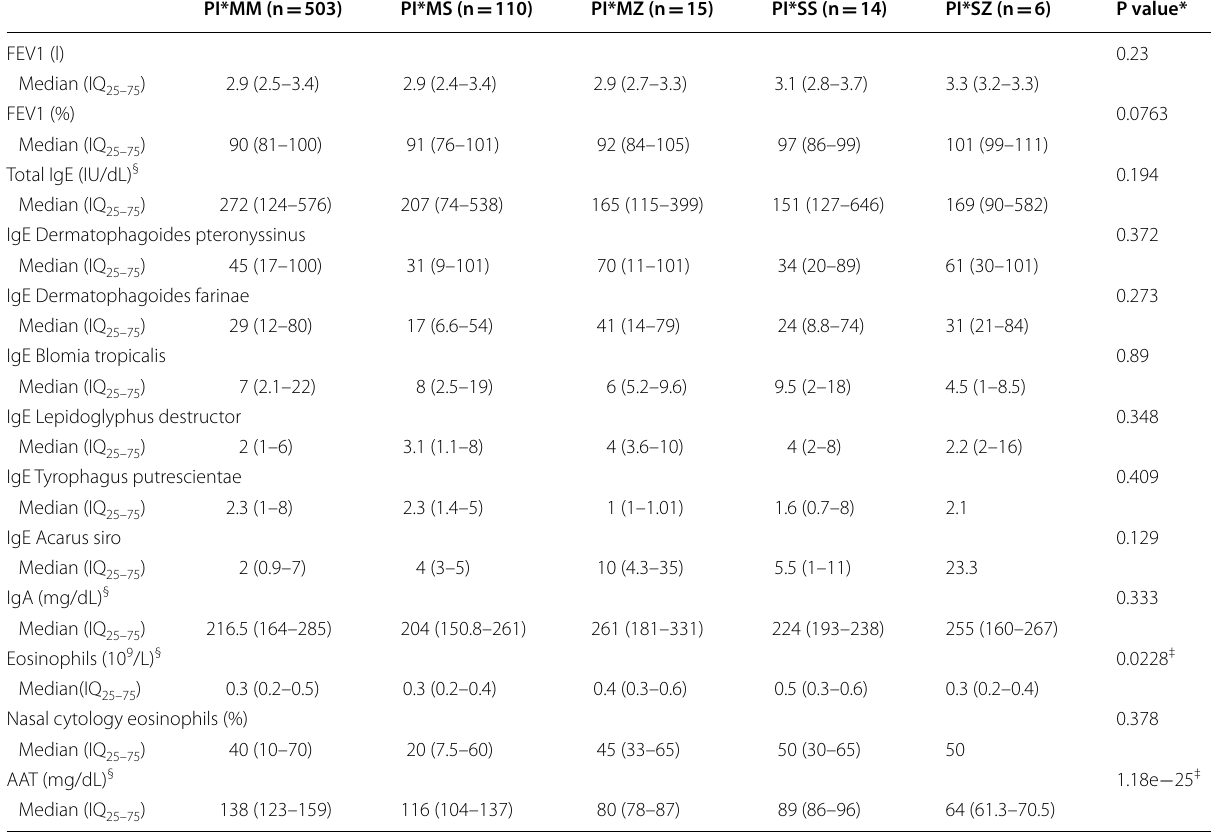
Table 3 Analytical and functional respiratory tests according to alpha 1 antitrypsin genotype